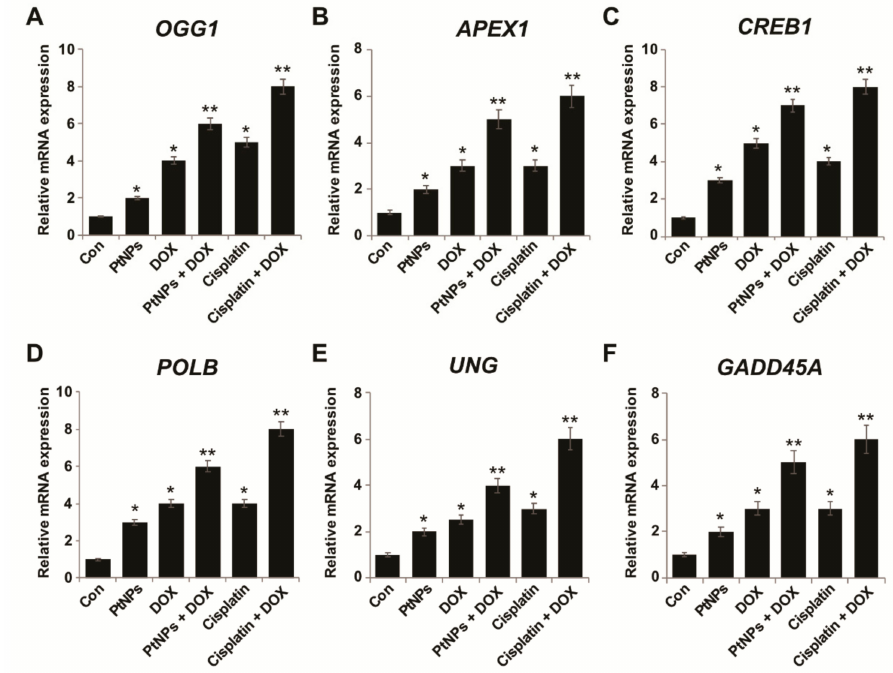
Figure 14. PtNPs aberrantly upregulate DNA damage and repair genes ( A – F ). U2OS cells were treated with PtNPs (10 µ g / mL), DOX (1 µ g / mL), CIS (5 µ g / mL), or a combination of PtNPs (10 µ g / mL) and DOX (1 µ g / mL) or combination of DOX (1 µ g / mL) and CIS (5 µ g / mL) for 24 h and the relative mRNA expression of DNA damage genes was analyzed by quantitative RT-PCR. Expression was determined as the fold change compared to GAPDH expression. Di ff erences between the treated and control groups were measured using Student’s t -test and statistically significant di ff erences are indicated by * ( p < 0.05). The results are presented as mean ± standard deviation of three experiments. * p < 0.05 was considered significant; ** p < 0.01 was considered highly significant and *** p < 0.001 was considered very highly